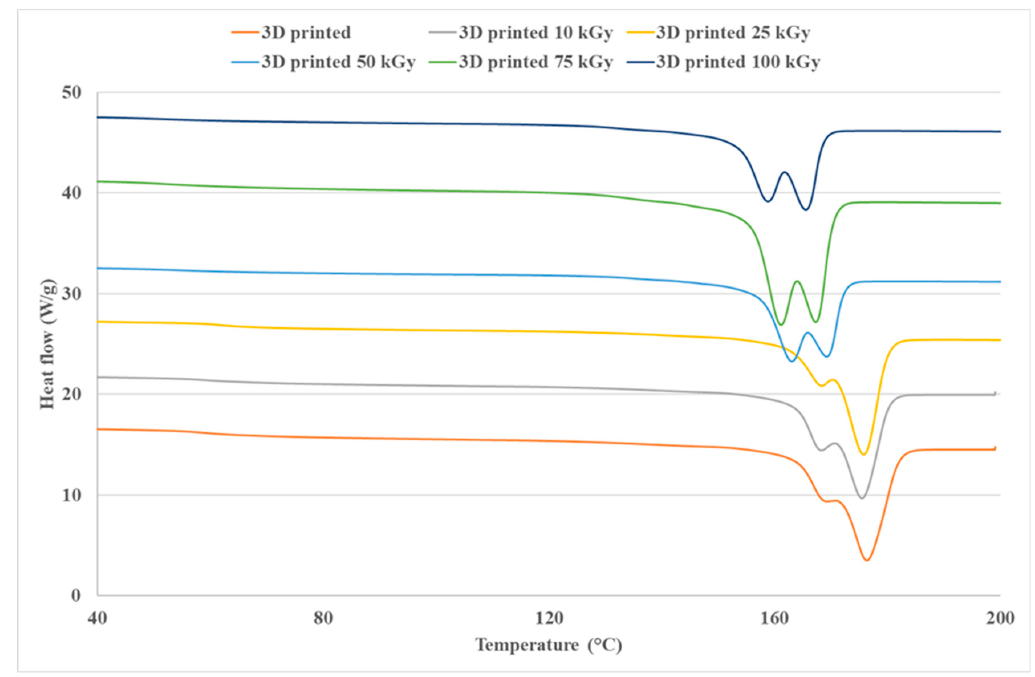
Figure 2. Thermograms of the second heating run of 3D-printed PLA samples after EB treatment at various doses.